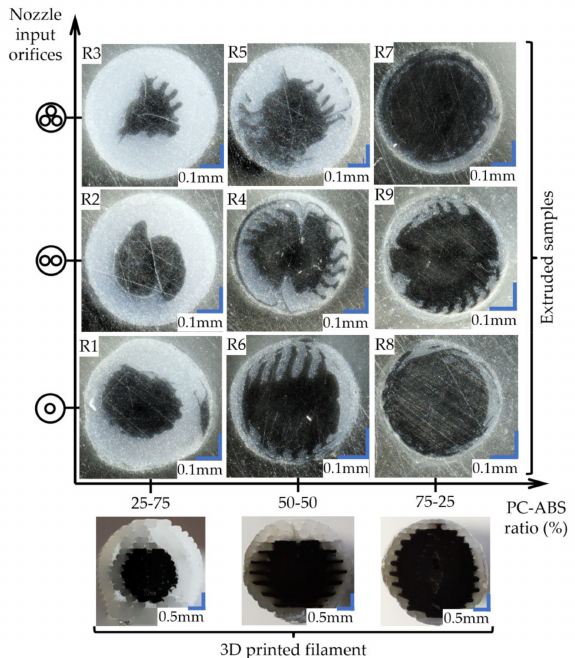
Figure 3. Cross-sectional images of the extruded coaxial filament (300 × magnification) and the 3D printed filament cross-section